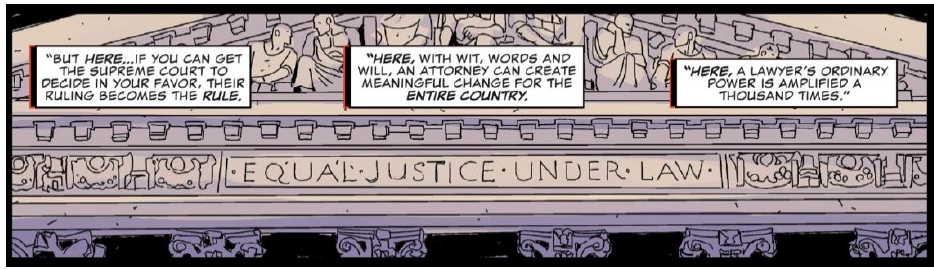
Figure 14. Panel from Soule’s Daredevil: Back in Black Vol. 5: Supreme #25, 2017. Image Credit: Alec Morgan © 2017 Marvel Characters,